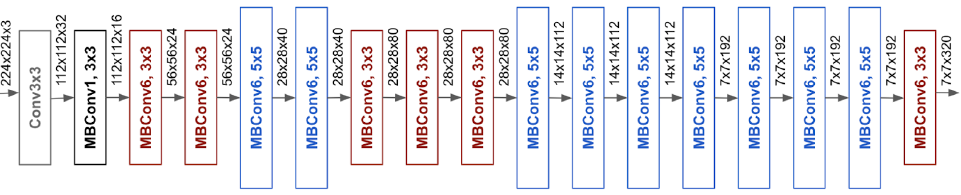
Figure 3. The architecture of